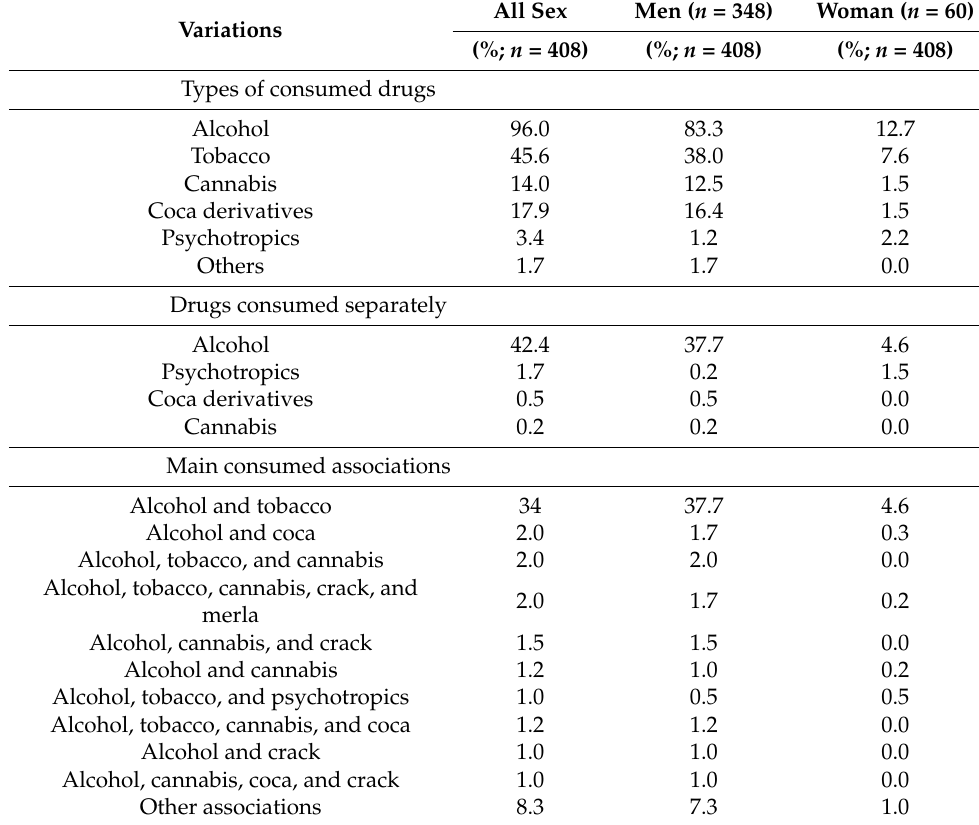
Table 2. Profile of the use of legal and illegal drugs by the elderly assisted by CAPS-AD from DF between 2000 and 2017.